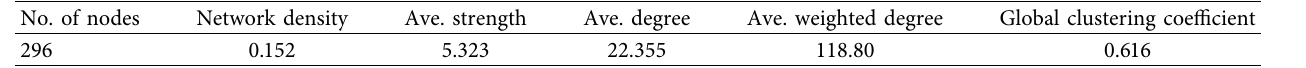
Figure 3: An overview of the 2013 and 2014 co-consideration network. (a) The blue nodes represent car models and black links represent co- consideration relations. The node size is proportional to the weighted degree of a car model, and the link width is proportional to the link strength of the co-consideration relation. And, an example of the local co-consideration network between three cars changing from 2013 to 2014 (b). Table 1: Summary of 2013 co-consideration network descriptive